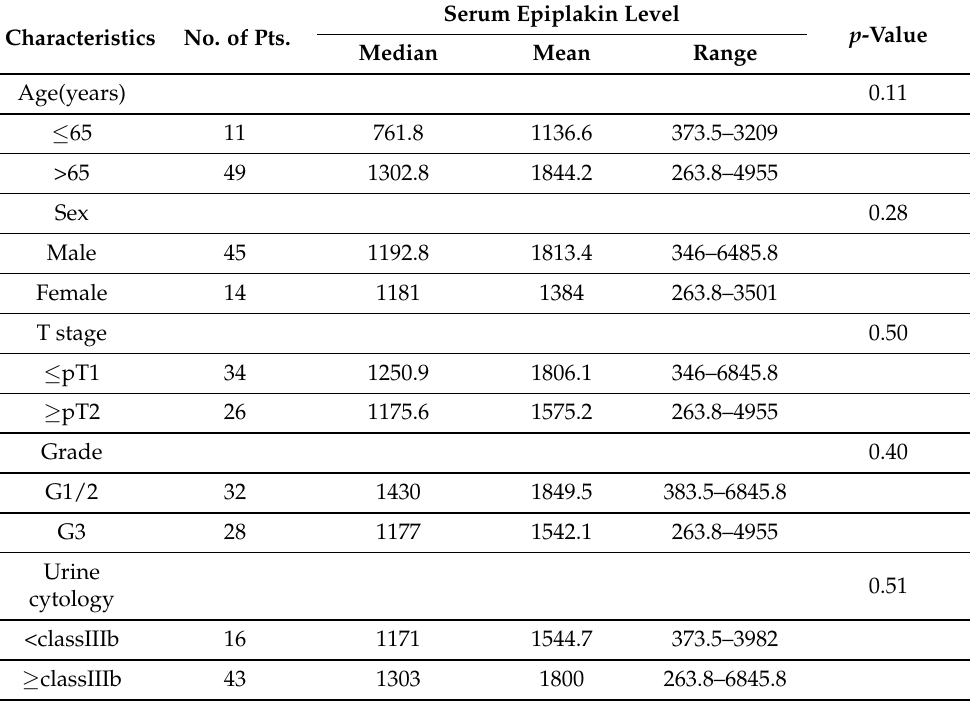
Table 1. The relationships between of serum epiplakin levels and clinicopathological features.